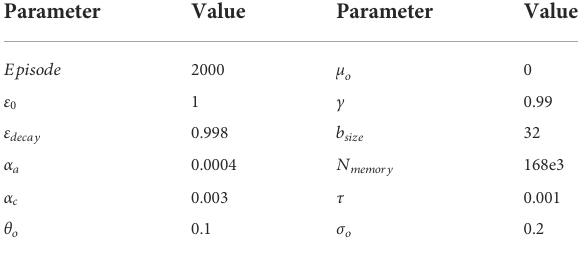
methods — MPC, DDPG, and the TD3 approach — are